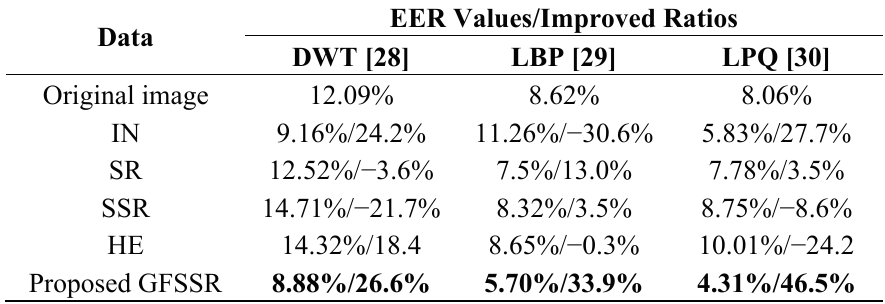
Figure 12. ROC curves of different image enhancement methods on UTFVP using different feature extraction algorithms: ( a ) DWT method; ( b ) LBP method; and ( c ) LPQ method. Table 2. EER values and their improved ratio achieved using different feature extraction algorithms on